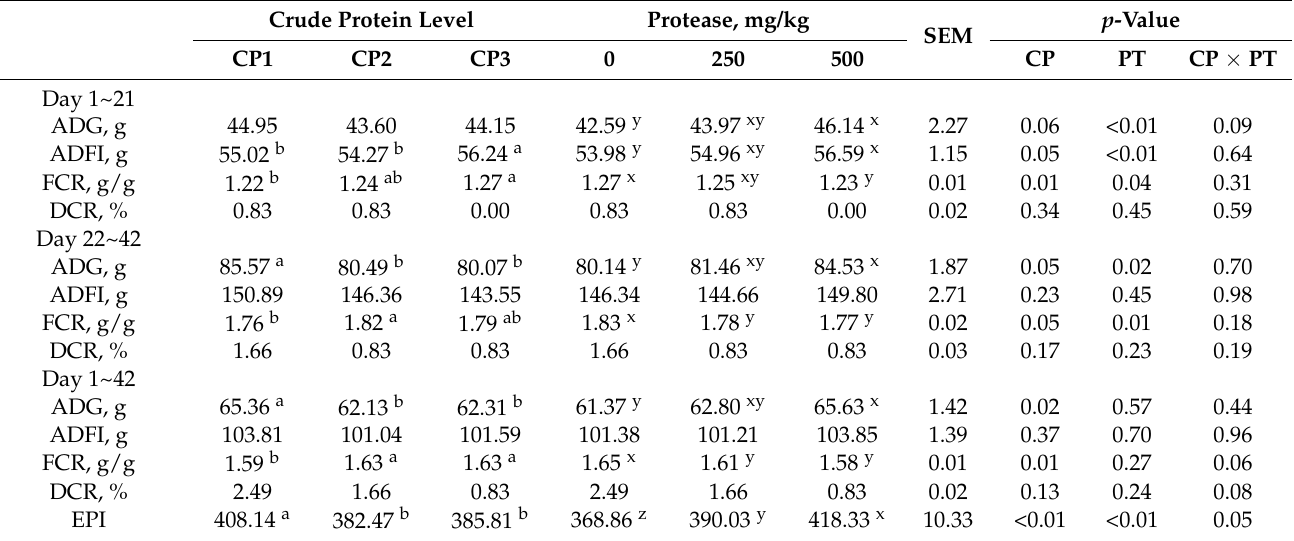
Table 3. Effects of dietary crude protein and protease levels on growth performance of broilers. Crude Protein Level